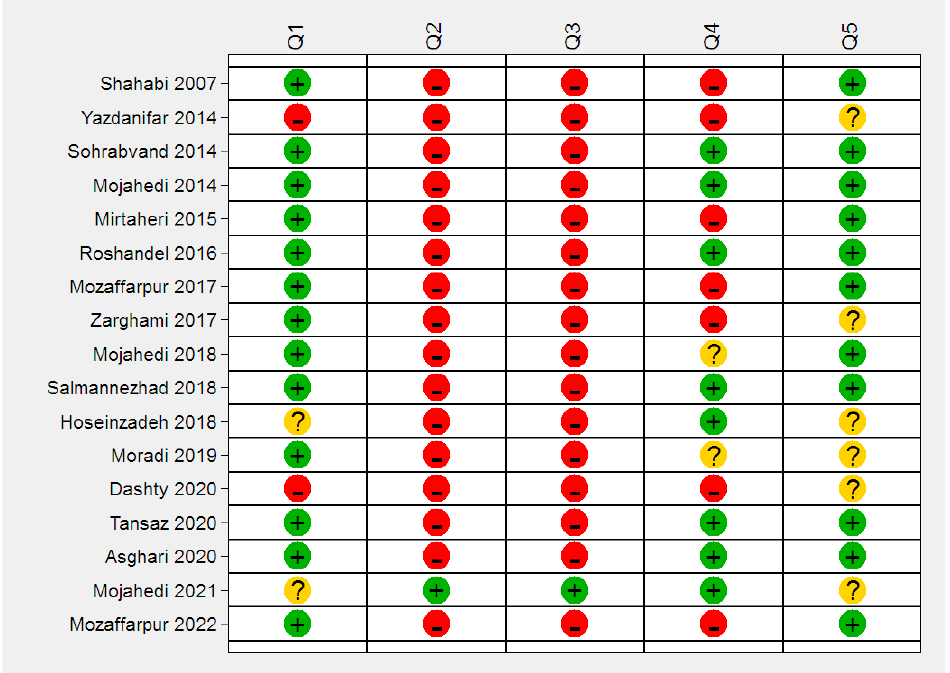
Figure 2. Critical appraisal of primarily included studies. Q1 = Was the diagnostic test evaluated in a representative spectrum of patients (like those on whom it would be used in practice)? Q2 = Was the reference standard applied regardless of the index test result? Q3 = Was there an independent blind comparison between the index test and an appropriate reference (‘gold’) standard of diagnosis? Q4 = Are test characteristics presented? Q5 = Were the methods for performing the test described in sufficient detail to permit replication? Each row of the figure corresponds to a critical evaluation of the articles: Shahabi [8], Yazdanifar [18], Sohrabvand [25], Mojahedi [5], Mirtaheri [26], Roshandel [29], Mozaffarpur [36], Zarghami [17], Mojahedi [41], Salmannezhad[20], Hoseinzadeh [23], Moradi [44], Dashty [19], Tansaz [22], Asghari [53], Mojahedi [60], Mozaffarpur [67].